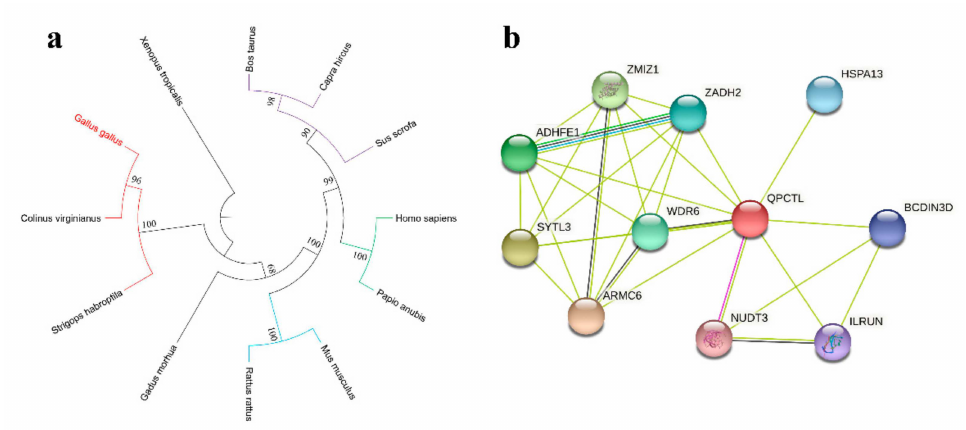
Figure 1. Bioinformatics prediction of QPCTL . ( a ) Phylogenetic tree of chicken QPCTL . Gallus gallus (chicken), Colinus virginianus (northern bobwhite), Strigops habroptila (kakapo), Bos taurus (cattle), Capra hircus (goat), Sus scrofa (pig), Homo sapiens (human), Papio anubis (olive baboon), Mus musculus (house mouse), Rattus rattus (black rat), and Xenopus tropicalis (tropical clawed frog). ( b ) Interacting proteins of chicken QPCTL . The purple line represents the interaction that has been verified by experiments, the black line represents the co-expression relationship, the yellow line represents text mining, and the blue line represents the gene